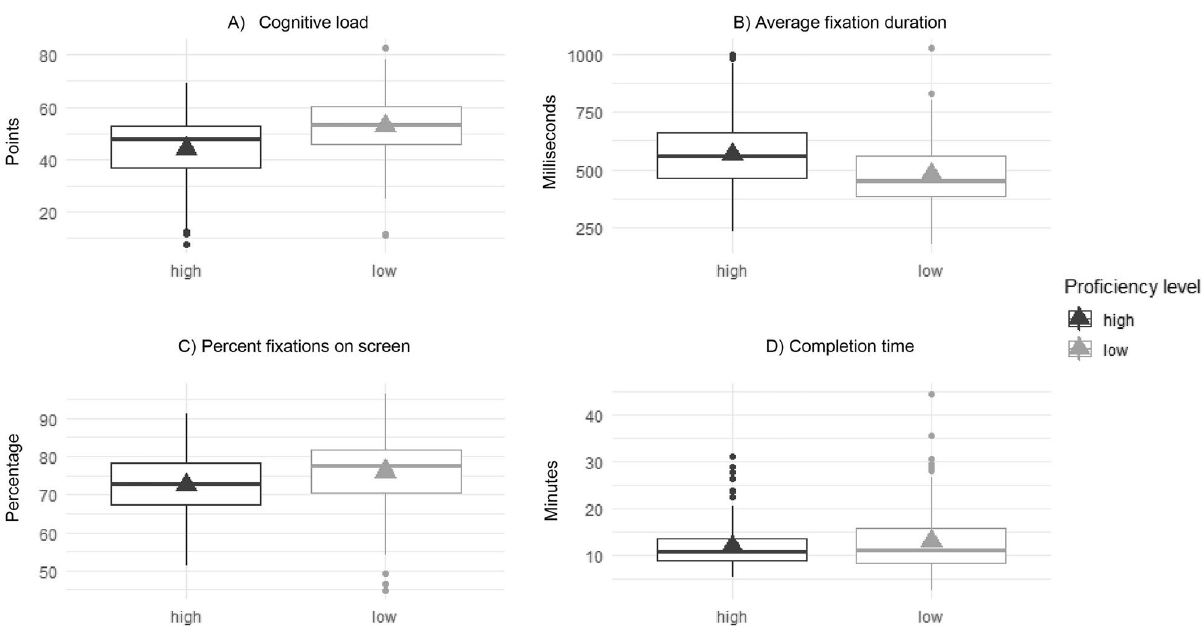
Figure 4. Differences in dependant variables between proficiency levels. Triangles depict the mean. Horizontal lines represent the median. The box depicts 50% of values (25th and 75th percentile) and the whiskers above and below the box mark the 90th and 10th percentiles. Points are